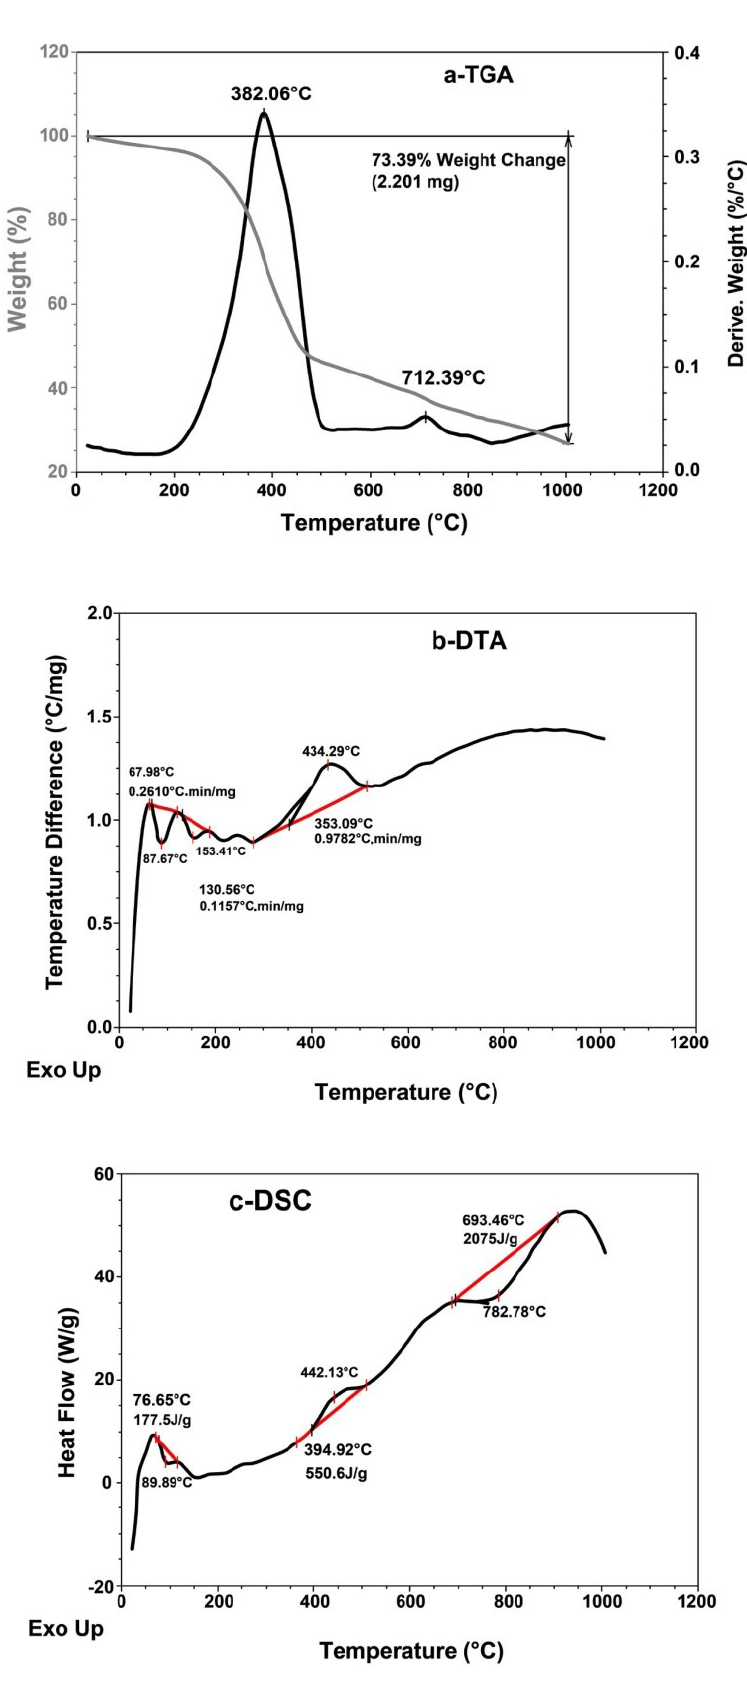
Figure 4. ( a ) TGA, ( b ) DTA and ( c ) DSC thermal analysis thermograms of original scrap tire sample. The crystalline decomposition temperature (T cr ) shows a 52.0% weight loss at 480 °C, which means that the rubber in the pristine tire has lost half of its weight at T max (382 °C), and that the crystalline structure of the tire composite collapses at T cr = (480 °C); this indi- cates that the pristine tire is thermally stable. The DTA thermogram (Figure 4b and Table 2) shows three maxima at 68 °C, 131 °C and 353 °C, with rubber decomposition rates of 0.26, 0.12 and 0.98 °C.min/mg, respec- tively, which means that the rate of rubber decomposition increases with an increase in temperature. However, the rate of rubber decomposition is still low at a high temperature.